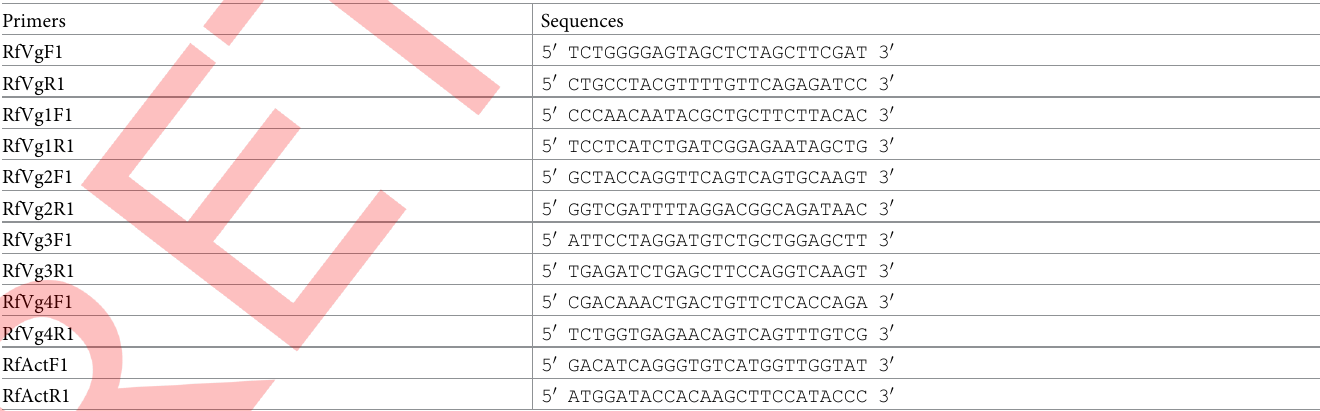
Table 1. List of primers used for confirmation of the identified RfVg genes via RT-PCR. Primers